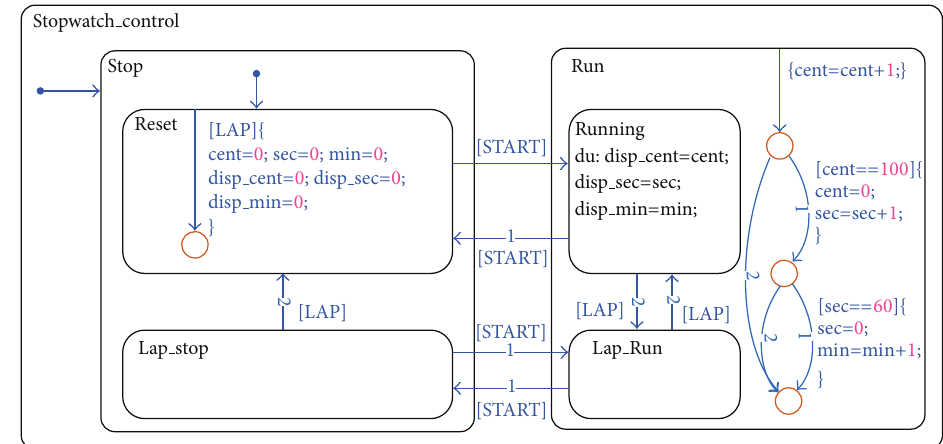
Figure 3: Sample of SL/SF model: stopwatch.